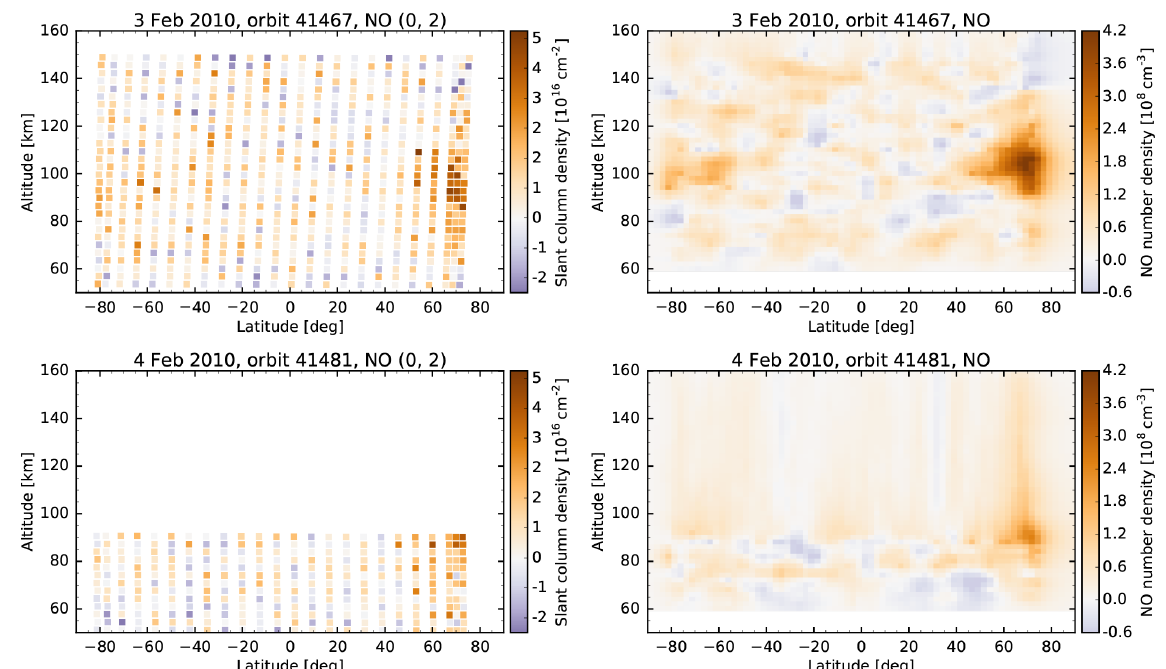
Figure 1. NO slant column densities from the (0, 2) gamma band (left column) and retrieved number densities from all used gamma bands (right column) along one SCIAMACHY MLT orbit (no. 41467, 3 February 2010, top row) and one nominal orbit (no. 41481, 4 February 2010, bottom row).